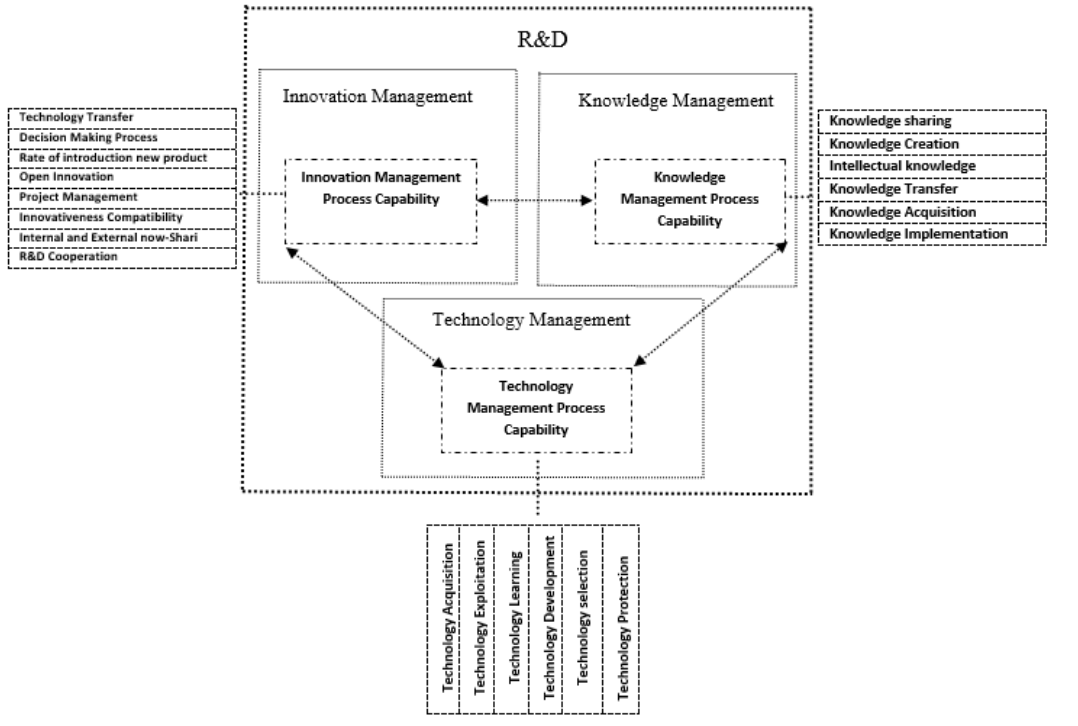
Figure 5. The study framework.